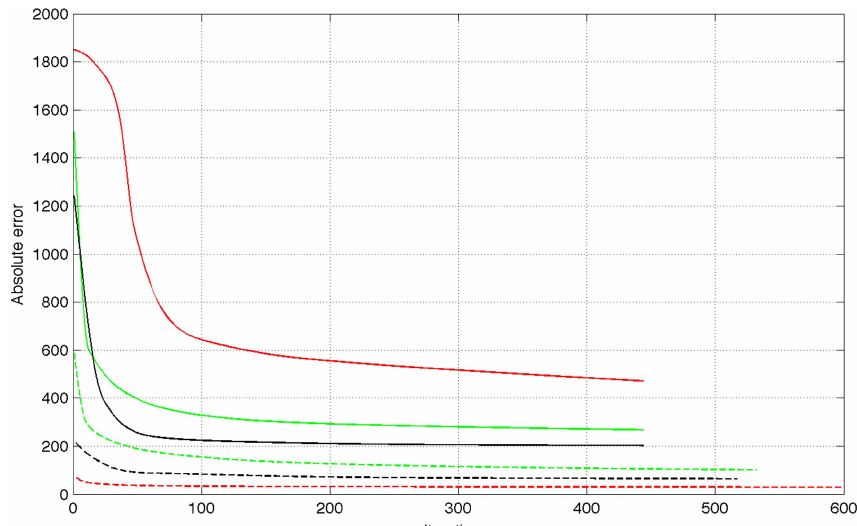
Figure 2. Structure of the artificial neural network.